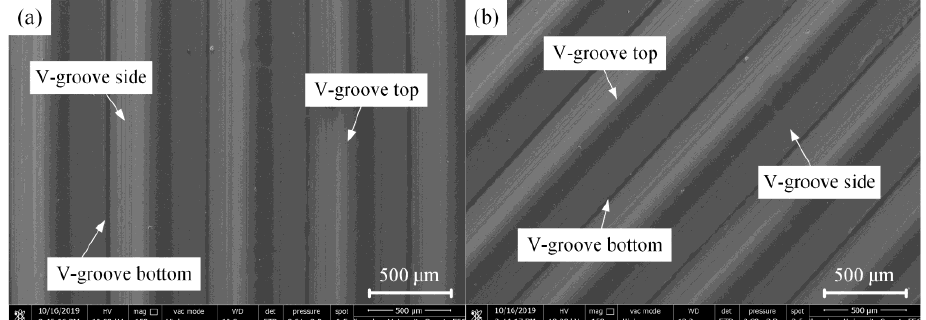
Figure 11. SEM photos of the injection molded micro-structured diffusion plate sample under different orientations: ( a ) vertical; ( b ) inclined.